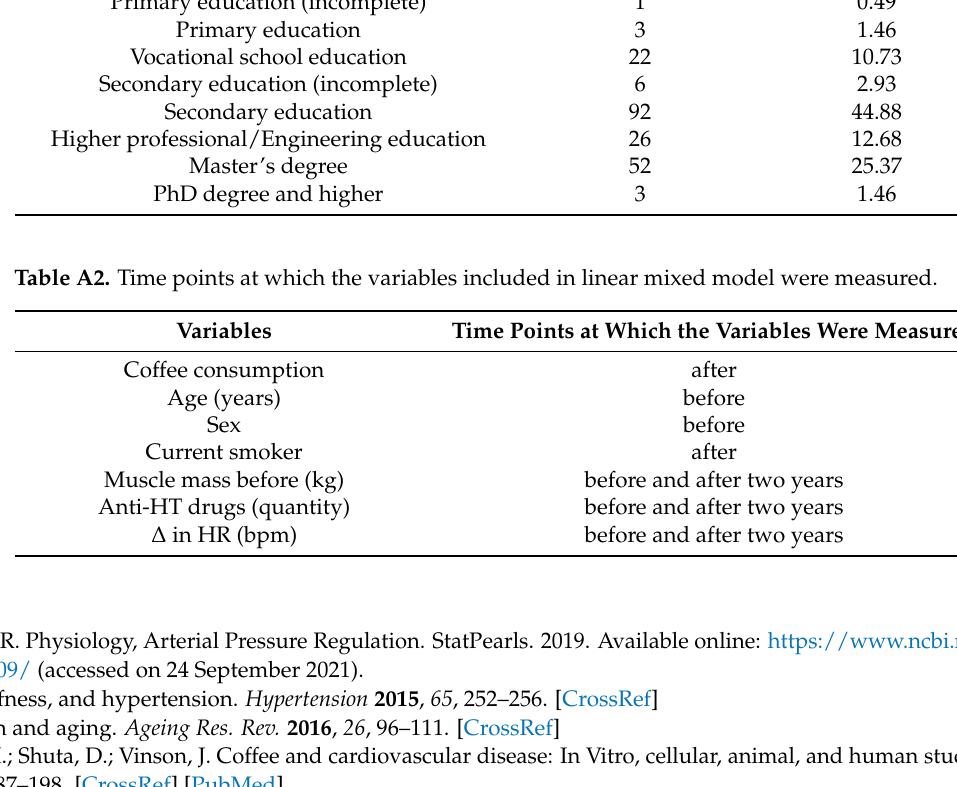
Table A1. Distribution of education categories in the re-examined group. Category